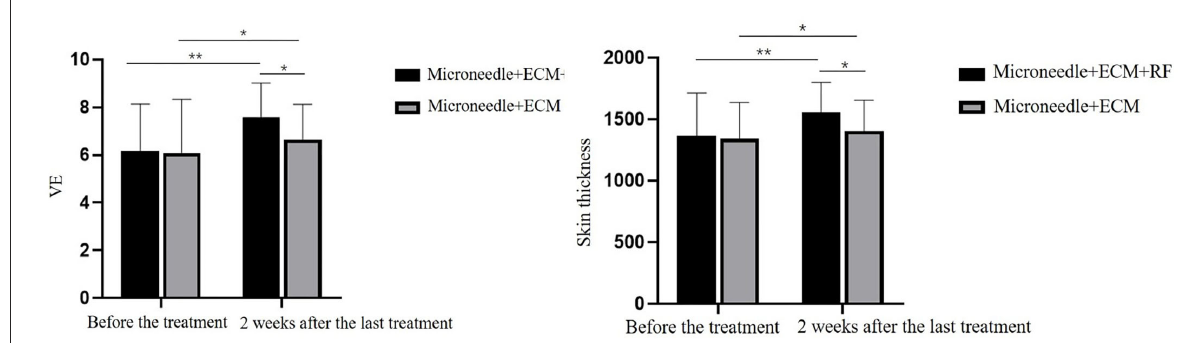
Before the treatment